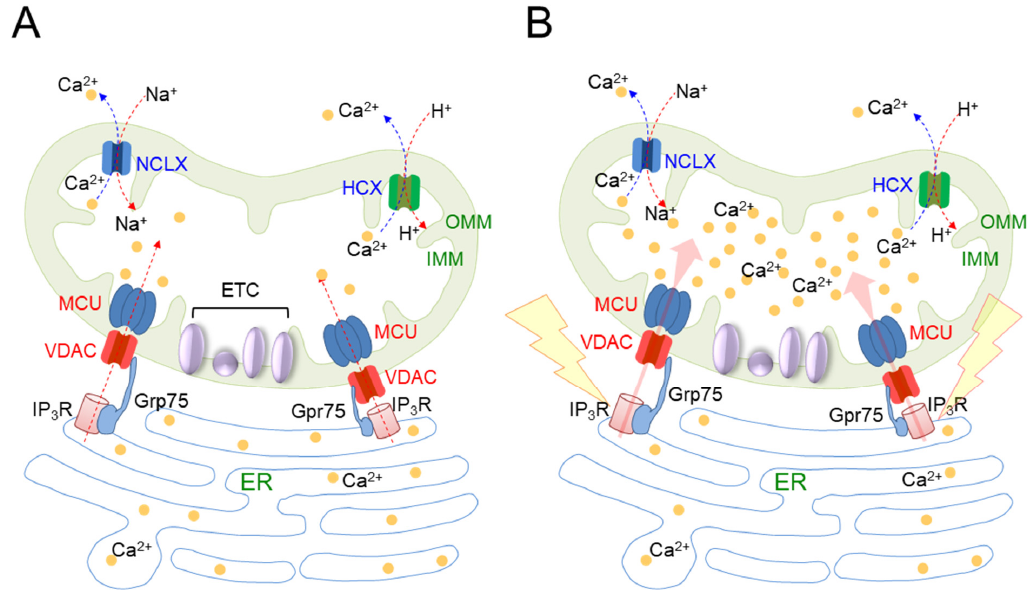
Figure 2. Fundamental mechanism of mitochondrial Ca 2+ homeostasis: ( A ) Mitochondrial homeostasis is primarily regulated by mitochondrial Ca 2+ concentration. Mitochondrial Ca 2+ concentration is controlled by channels in the mitochondria and in the endoplasmic reticulum (ER). VDAC: voltage-dependent anion channels, MCU: mitochondrial calcium uniporter, HCX: H + /Ca 2+ exchanger, NCLX: Na + /Ca 2+ exchanger, IP 3 R: inositol 1,4,5-trisphosphate receptor. Orange dots represent Ca 2+ . ( B ) Senescence causes efflux of Ca 2+ from the IP 3 R. Ca 2+ then starts to be transported to the mitochondria through the VDAC/MCU channel. Mitochondrial Ca 2+ overload induces mitochondrial ROS generation and senescence; the detailed mechanism will be further discussed in Section 3. Orange dots represent Ca 2+ . Lightning bolts represent senescence-associated stress. Pink arrows represent that large amounts of Ca 2+ are being transported to the mitochondria through the VDAC/MCU channel. Table 1. A summary of senescence-associated mitochondrial